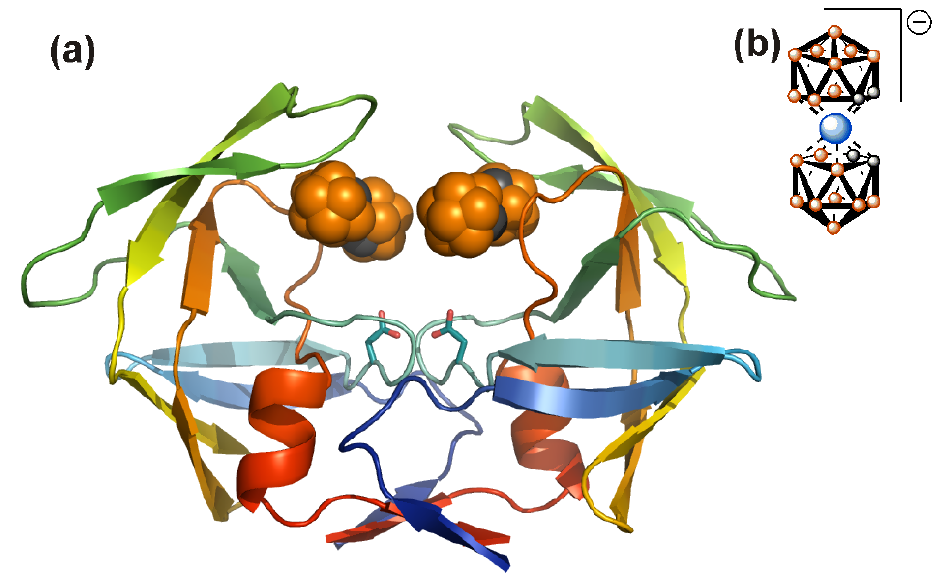
Figure 7. Crystal structure of metallacarborane inhibitor bound to HIV PR. (a) Two metallacarborane clusters bind to the flap-proximal part of the active site. The HIV PR is represented by a ribbon diagram and colored by rainbow from blue to red (N- to C- termini), the atoms of the metallacarborane cluster are represented by spheres and colored orange for boron atoms, gray for carbon atoms, and blue for cobalt. The structural formula is depicted in (b) . Hydrogens are omitted for